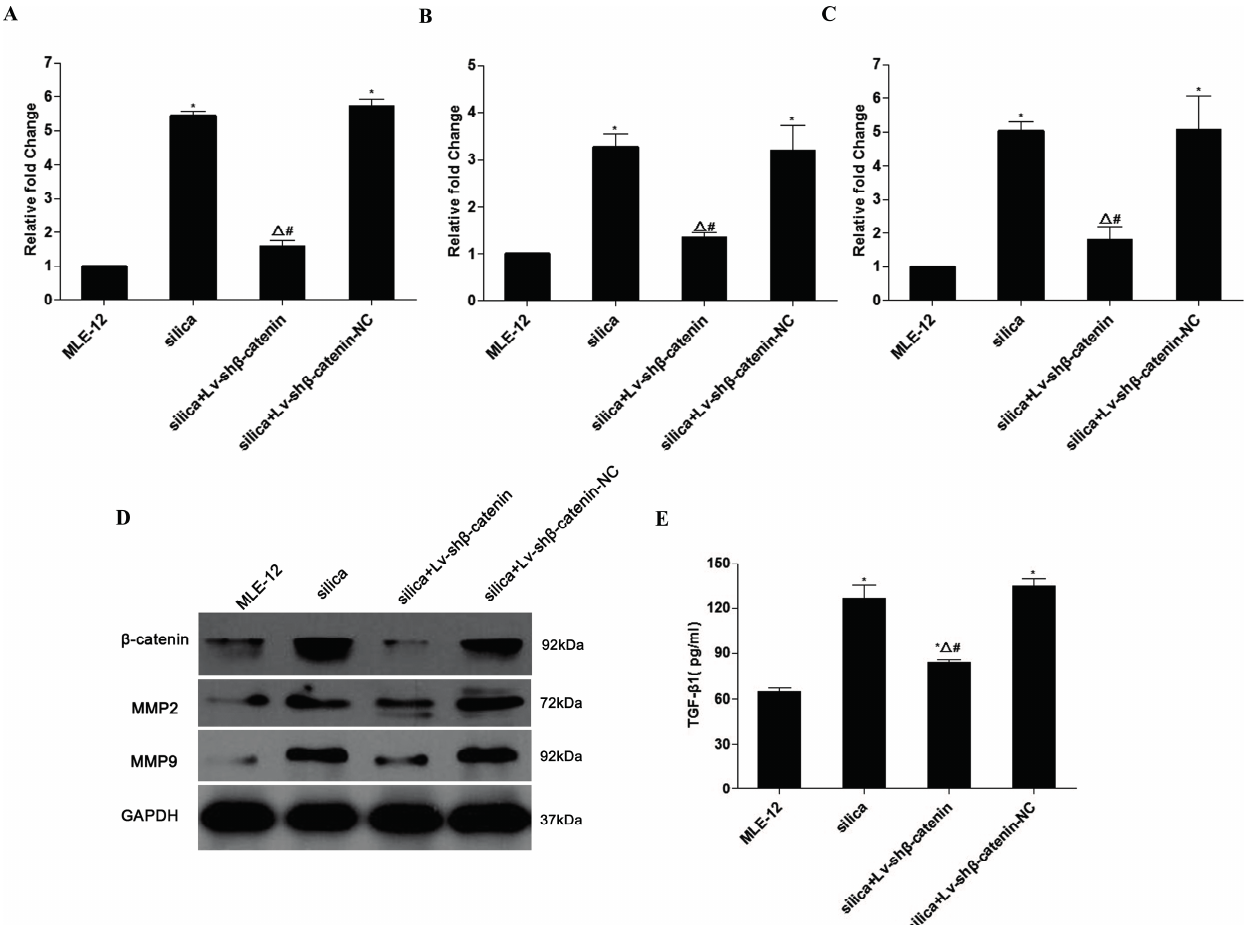
Figure 2 ． Effects of Lv-sh β -catenin on expression of β -catenin, MMP2, and MMP9, and secretion of TGF- β 1 in the silica-treated MLE-12 cells. ( A ) mRNA level of β -catenin. ( B ) mRNA level of MMP2. ( C ) mRNA level of MMP9. ( D ) Protein level of β -catenin, MMP2 and MMP9 in silica-treated MLE-12 cells assayed by western blot. ( E ) Level of TGF- β 1 in the supernatants of silica-treated MLE-12 cells determined by ELISA. Data are mean ± SEM (n = 3). * p < 0.05, compared to the MLE-12 group; Δ p < 0.05, compared